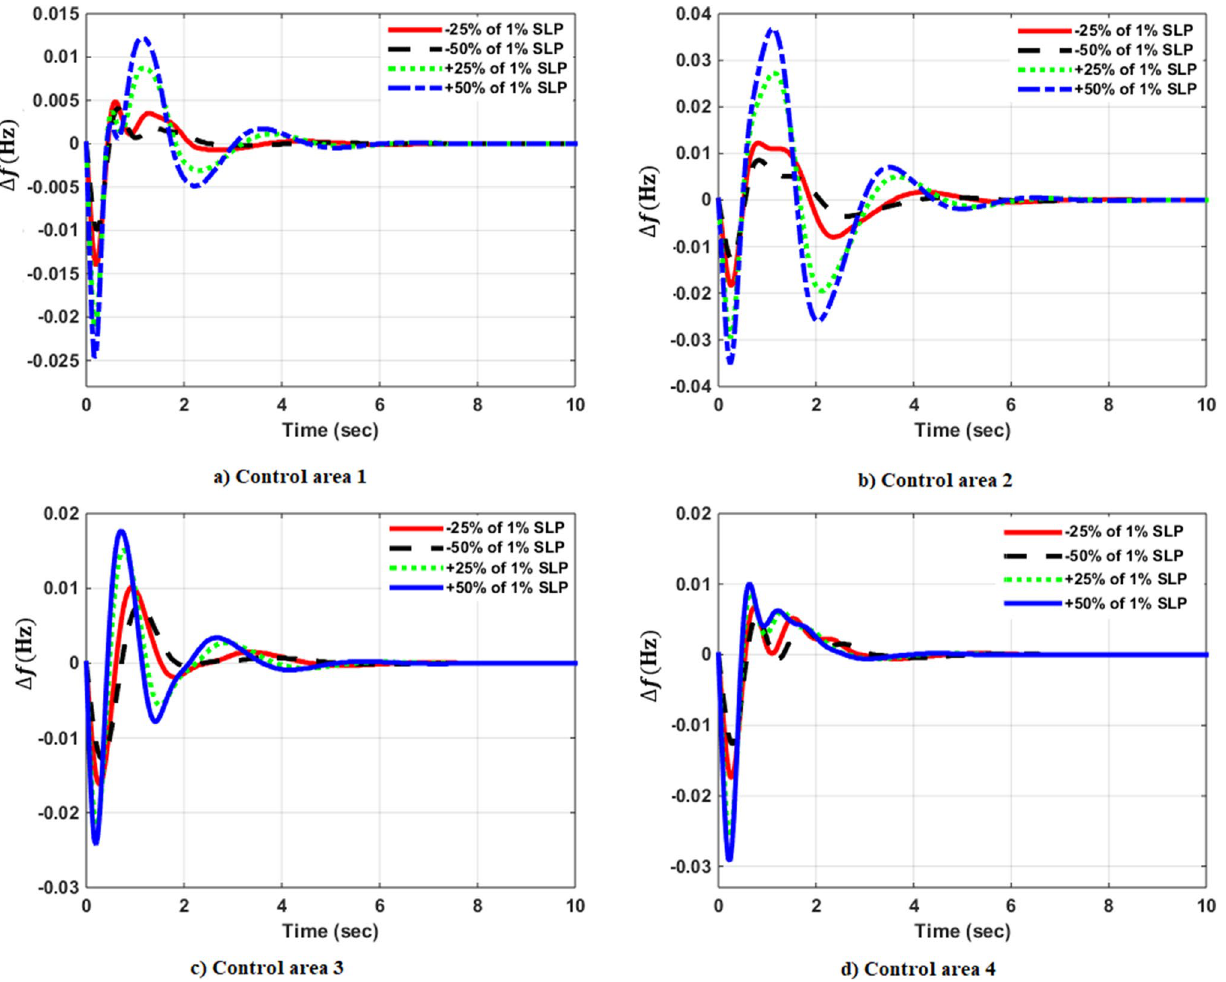
Figure 11. Dynamic response of Frequency deviations with ( a ) non-reheat turbine, ( b ) reheat turbine, ( c ) hydro turbine, ( d ) gas turbine when changes in % SLP applied at t = 0